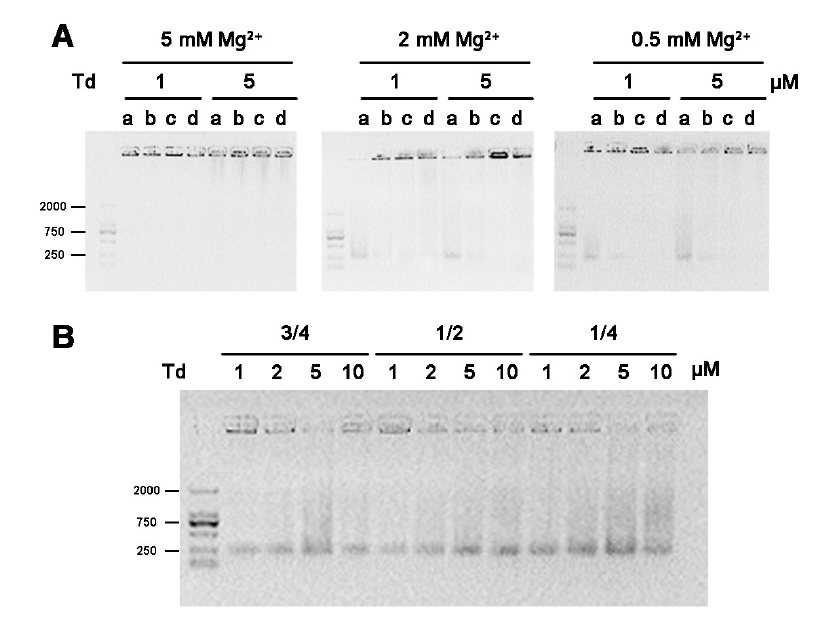
Figure 6. The influence of re-dissolving solvents and volumes on the stability of Td structure after freeze-drying. ( A ) Agarose gel electrophoresis of the re-dissolved 1 and 5 µ M Td solutions, which were prepared in bu ff er containing 5, 2, or 0.5 mM Mg 2 + . “a, b, c, d” represent di ff erent re-dissolving solvents: H 2 O, PBS, MHB and DMEM, respectively. ( B ) Agarose gel electrophoresis of 1, 2, 5 or 10 µ M Td re-dissolved in water, the volume of which was 3 / 4, 1 / 2 or 1 / 4 of the initial prepared bu ff er.